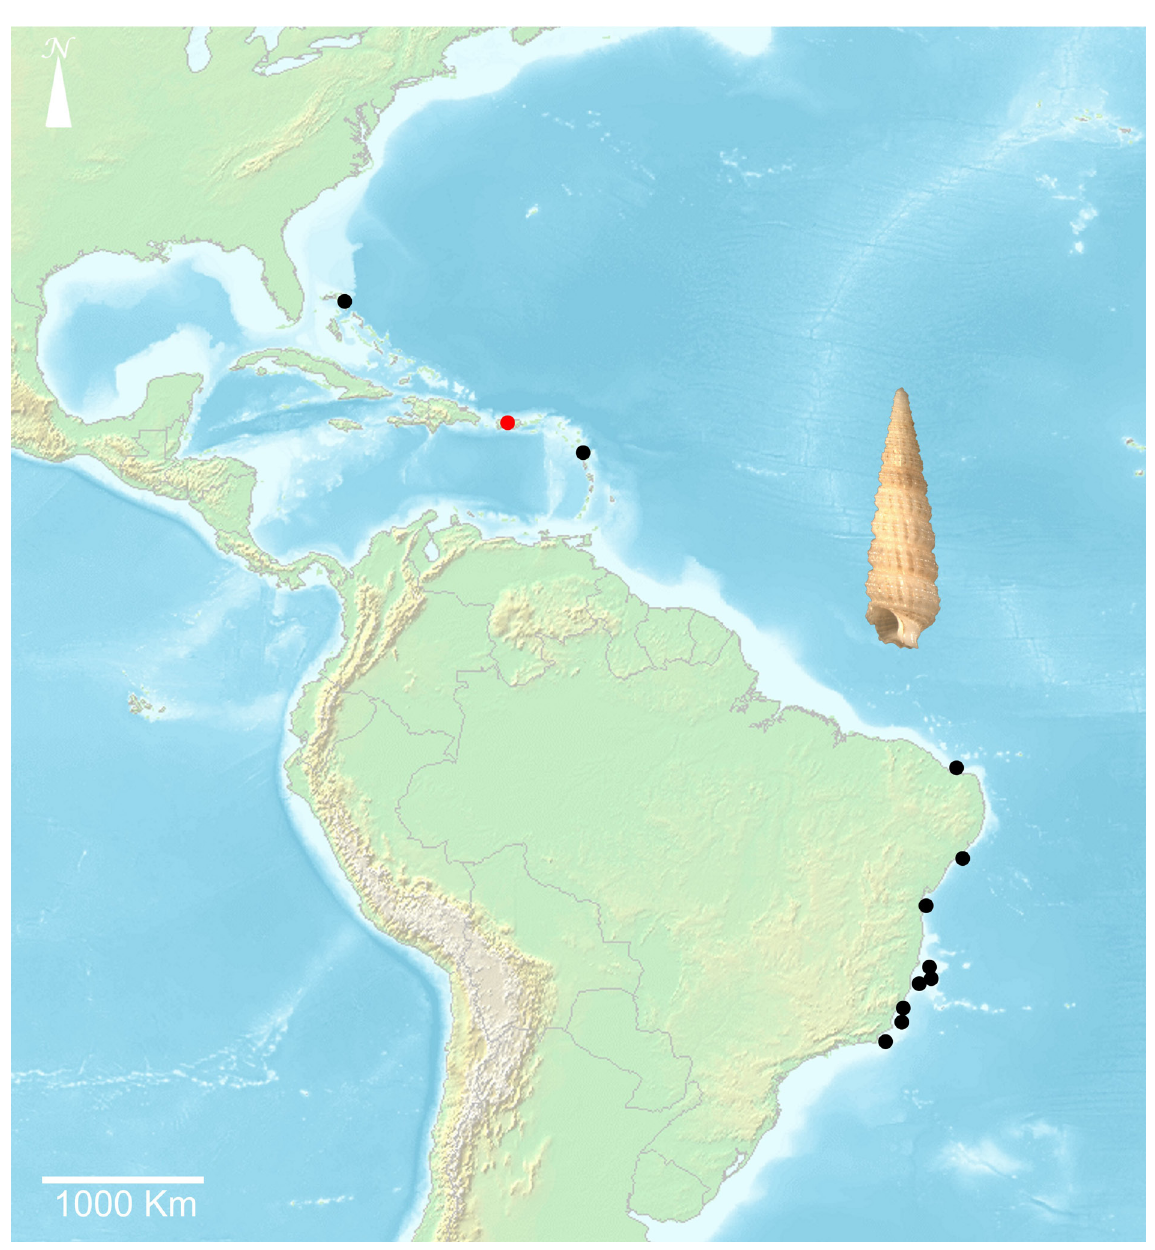
Fig. 80. Distribution map of Triphora portoricensis Rolán & Redfern, 2008; red circle = type